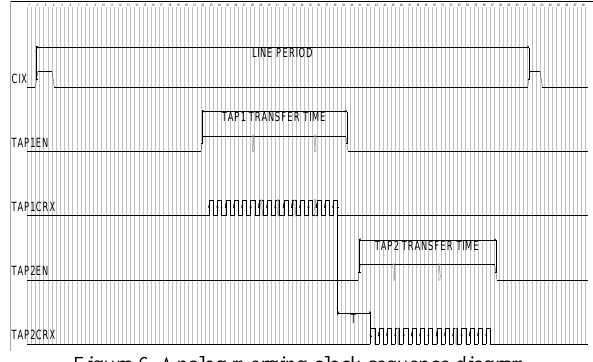
Figure 6. Analog merging clock sequence diagram